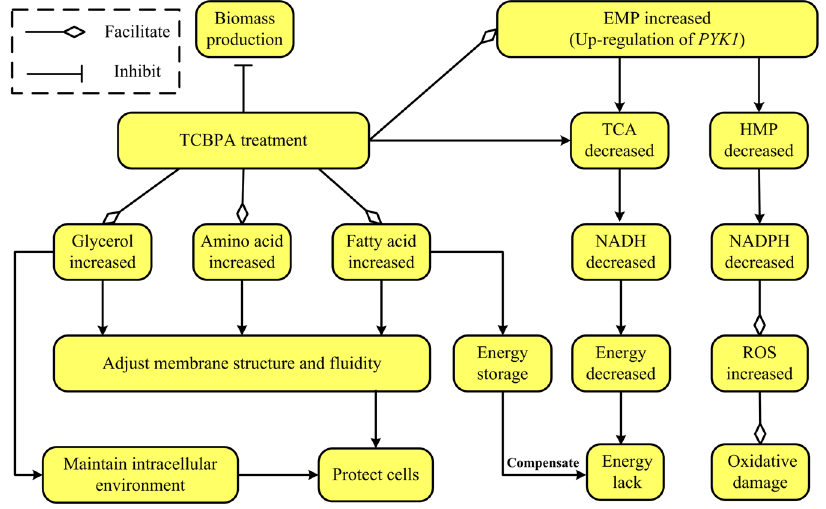
Figure 4. Overview of the effect of TCBPA treatment on metabolic changes in Saccharomyces cerevisiae